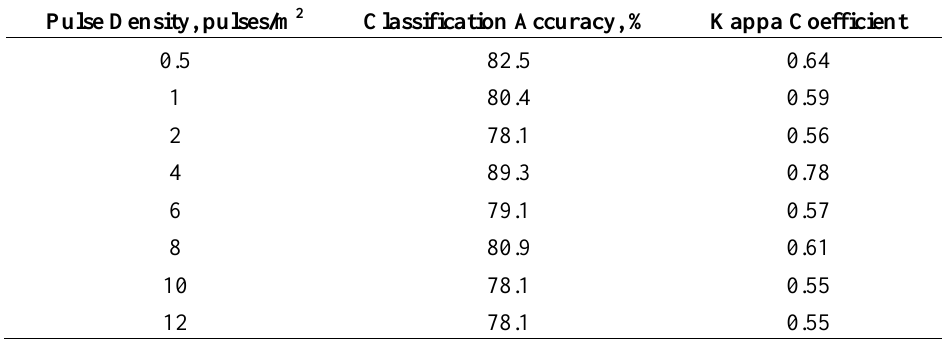
Table 3. Mapping accuracy of defoliation with various LiDAR data pulse